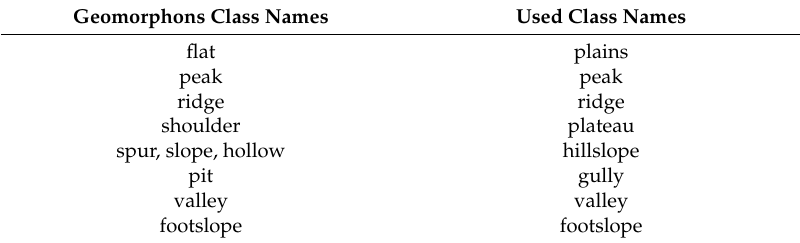
Table 5. Reclassification scheme of the derived landform to final landform classes used in this contribution for comparison of the approaches.